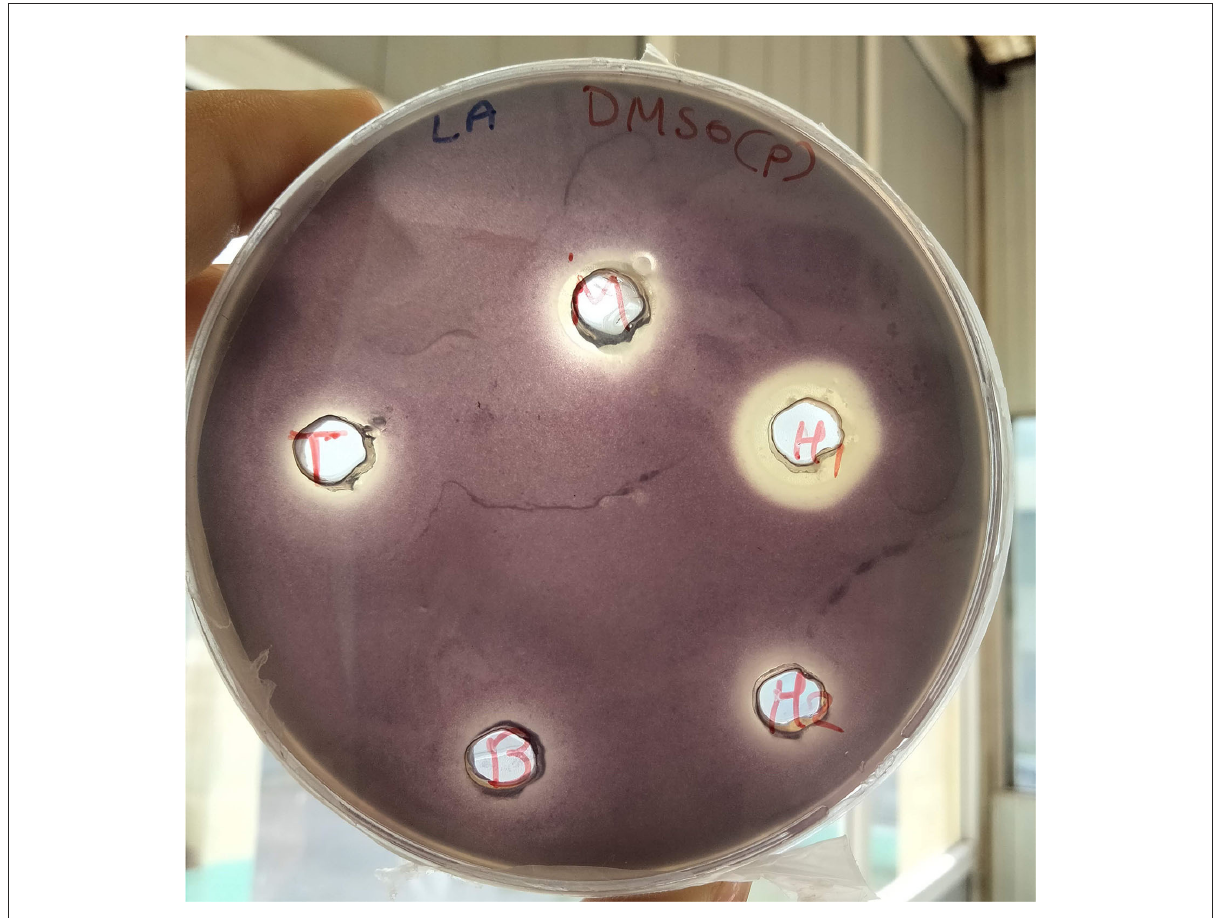
FIGURE2 Well diffusion assay of bacterial crude